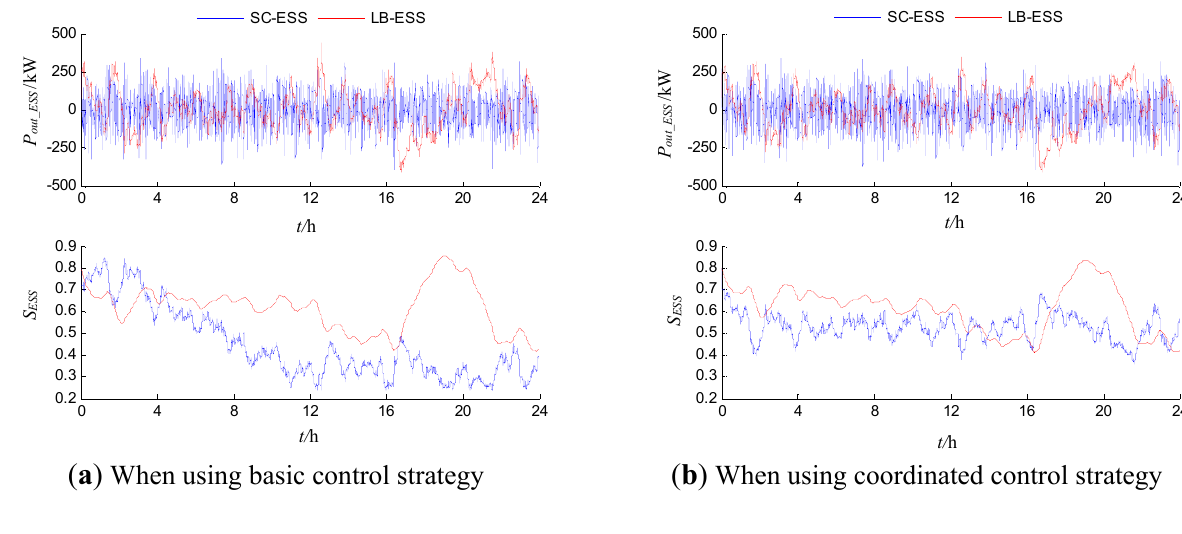
Figure 7. Output power and SOC of two ESSs using two strategies when T f = 30.